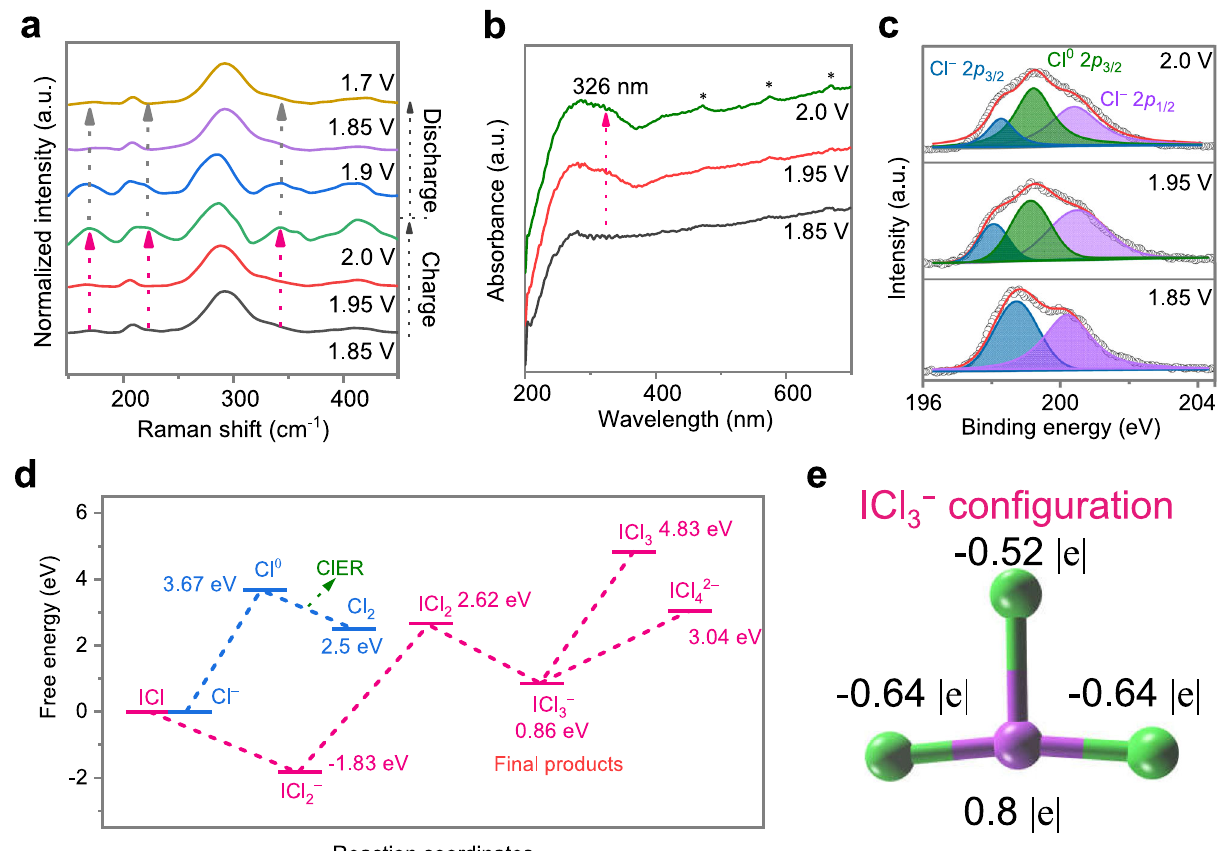
Fig. 3 | Spectroscopic and computational characterizations of ClRR. a In situ RamancharacterizationsofdifferentchargedanddischargedstatesoftheCl-redox reaction. b Ex situ UV ‒ vis results and c ex situ XPS to detect the Cl-I electrode at